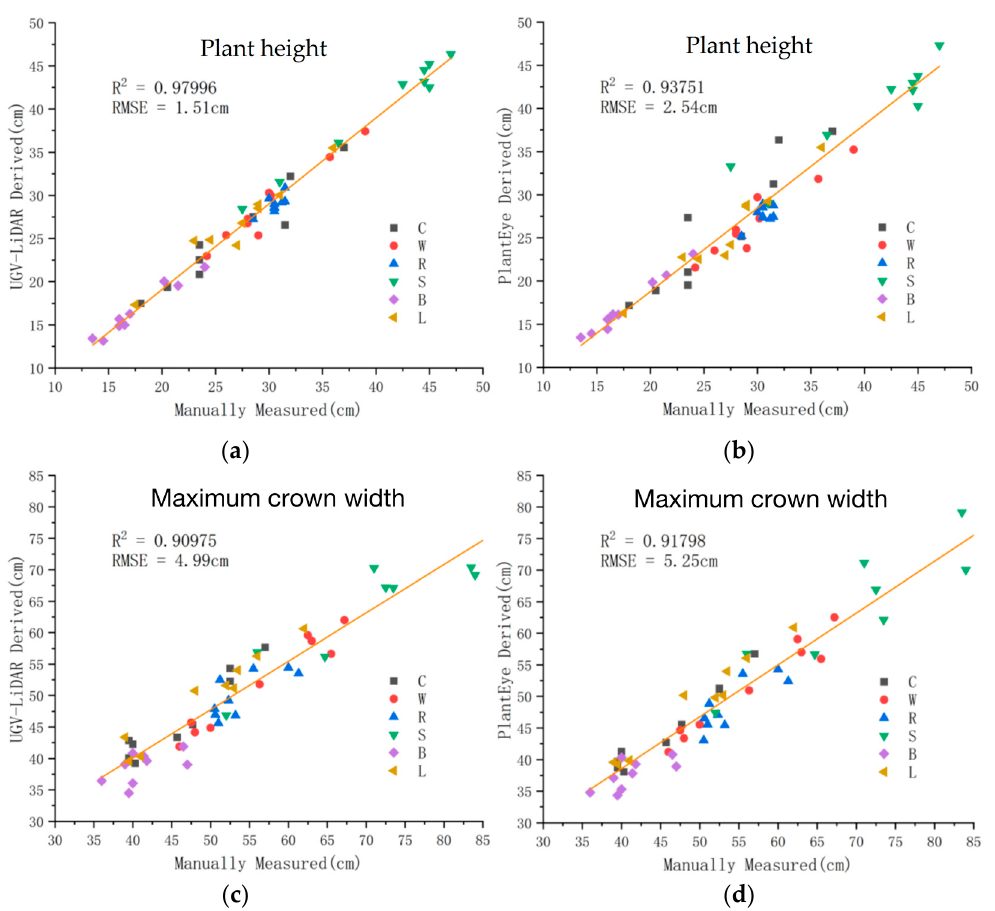
Figure 10. Comparison of plant height and maximum crown width extracted using the point cloud processing pipeline. ( a ) Linear fit of plant height estimated by point cloud obtained by UGV-LiDAR phenotyping system against manual measurements. ( b ) Linear fit of maximum crown width esti- mated by point cloud obtained by UGV-LiDAR phenotyping system against manual measurements. ( c ) Plant height estimated by point cloud obtained by PlantEye against manual measurements. ( d ) Linear fit of the maximum canopy width estimated by the point cloud obtained by PlantEye against manual measurements.